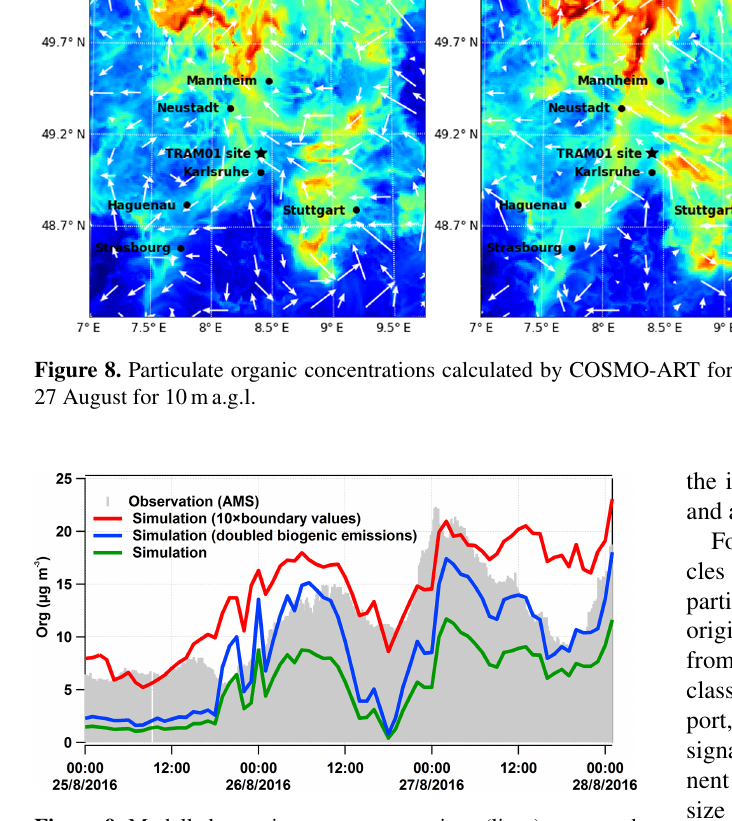
Figure 9. Modelled organic mass concentrations (lines) compared to measured values (grey area). The green line is the same as in Fig. 7, the red line was calculated for a 10-fold-enhanced regional background in organics, and the blue was calculated for doubled biogenic emissions in